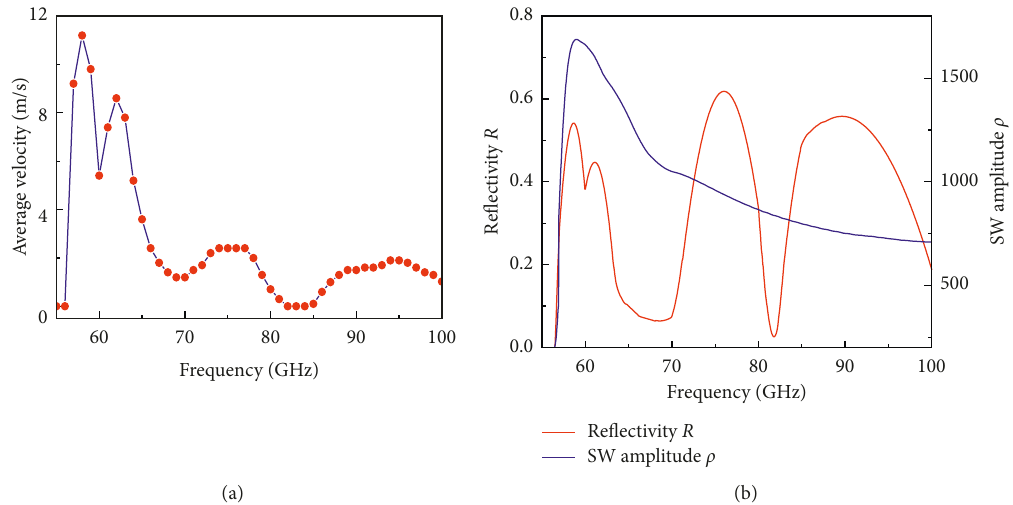
Figure 2: (a) The average velocity V of 20 nanoseconds versus the frequency f ; (b) the reflection coefficients R of the SW passing through the skyrmion (blue solid line) and the amplitude of the SW ρ (red solid line) as a function of